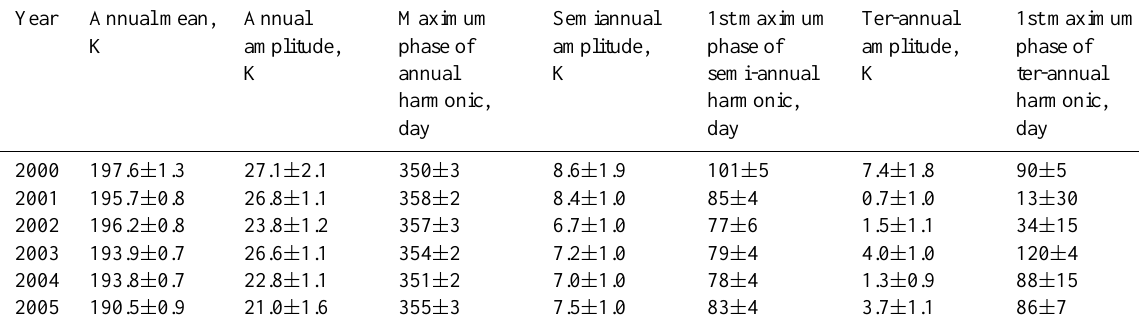
Table 5. Parameters of seasonal variations of hydroxyl